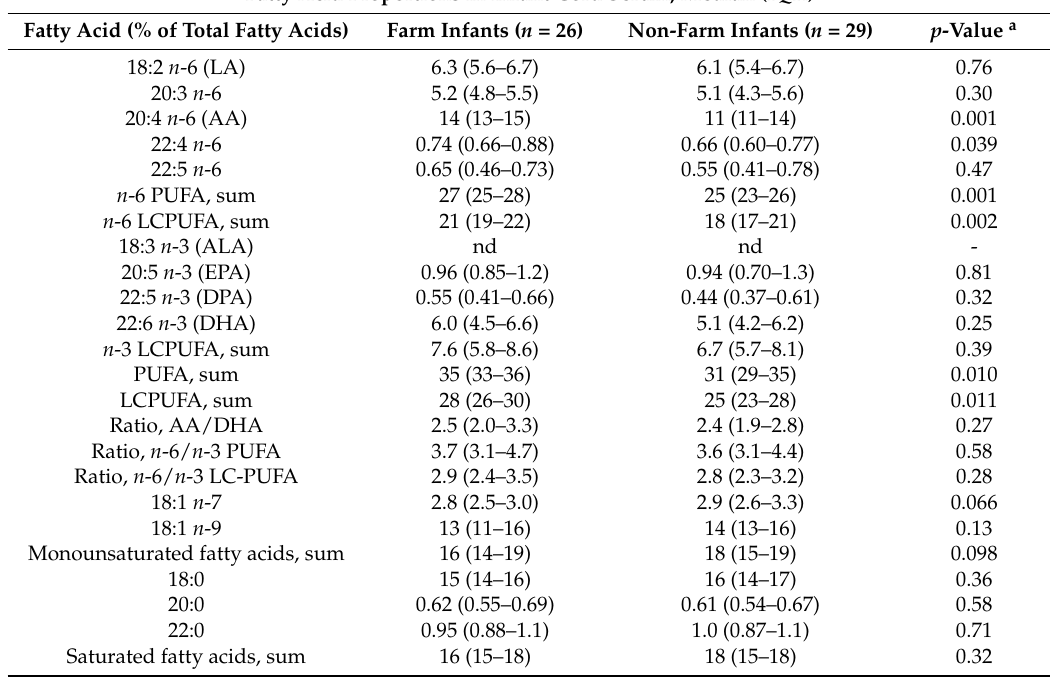
Table 1. Proportions of fatty acids (% of total phospholipid fatty acids) in the phospholipid fraction of cord sera of infants from farming and rural non-farming families.